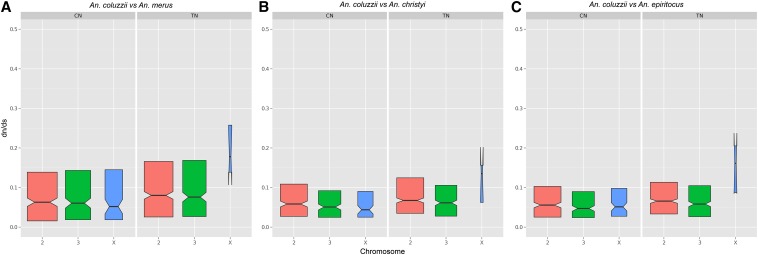
X-linked testes-biased genes exhibit extraordinary rates of evolution (A–C). Notched box-plots display the median, 25th, and 75th percentile values of dN/dS ratios (untransformed) between A. coluzzii and three comparator Anopheles species: A. merus (A), A. christyi (B), and A. epiroticus (C). dN/dS were assessed for tissue-enriched genes on each chromosome (TN and CN). The width of each box-plot is proportional to the square root of the sample size. TN genes located on the X show elevated dN/dS values relative to autosomal TN genes. Similar accelerated X-linked evolution is not seen in carcass-biased genes.